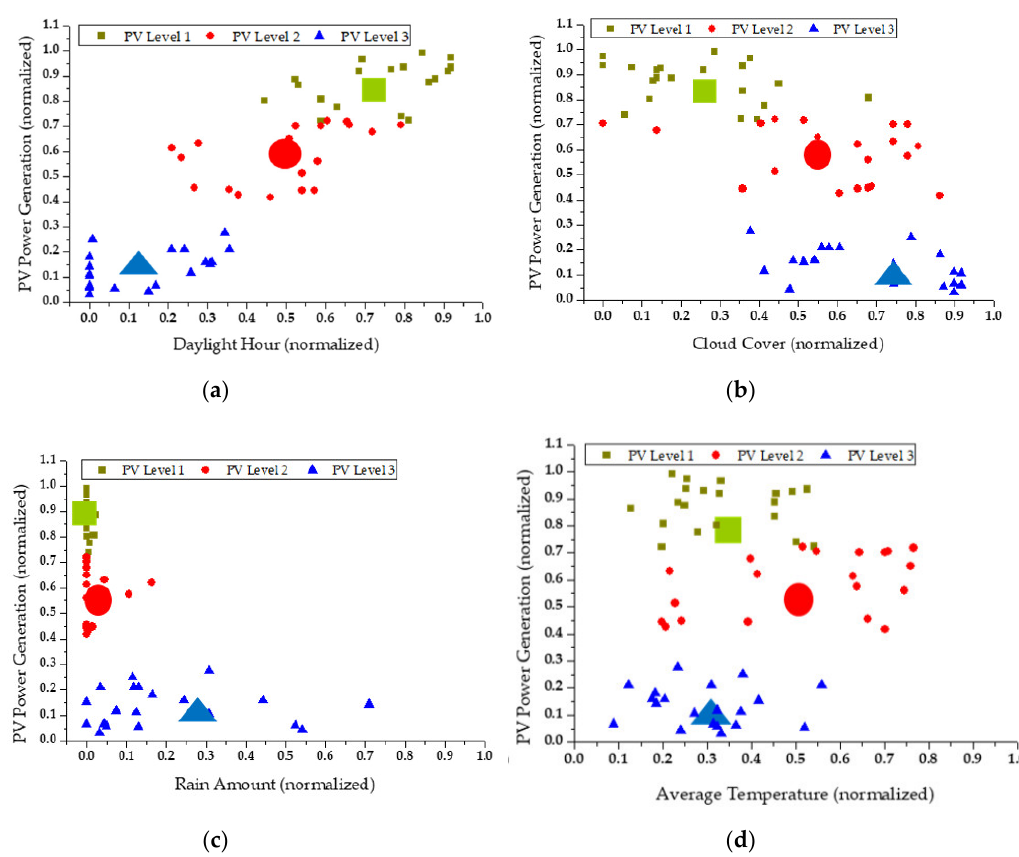
Figure 2. Distribution of weather variables according to PV power: ( a ) daylight hours, ( b ) cloud cover, ( c ) rain amount, and ( d ) average temperature.